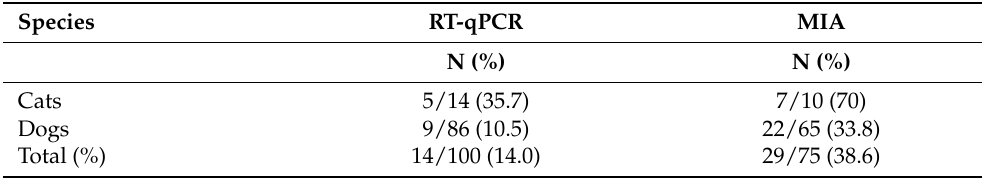
Table 2. Rate of SARS-CoV-2 detection by RT-qPCR and MIA in pets from Congo.